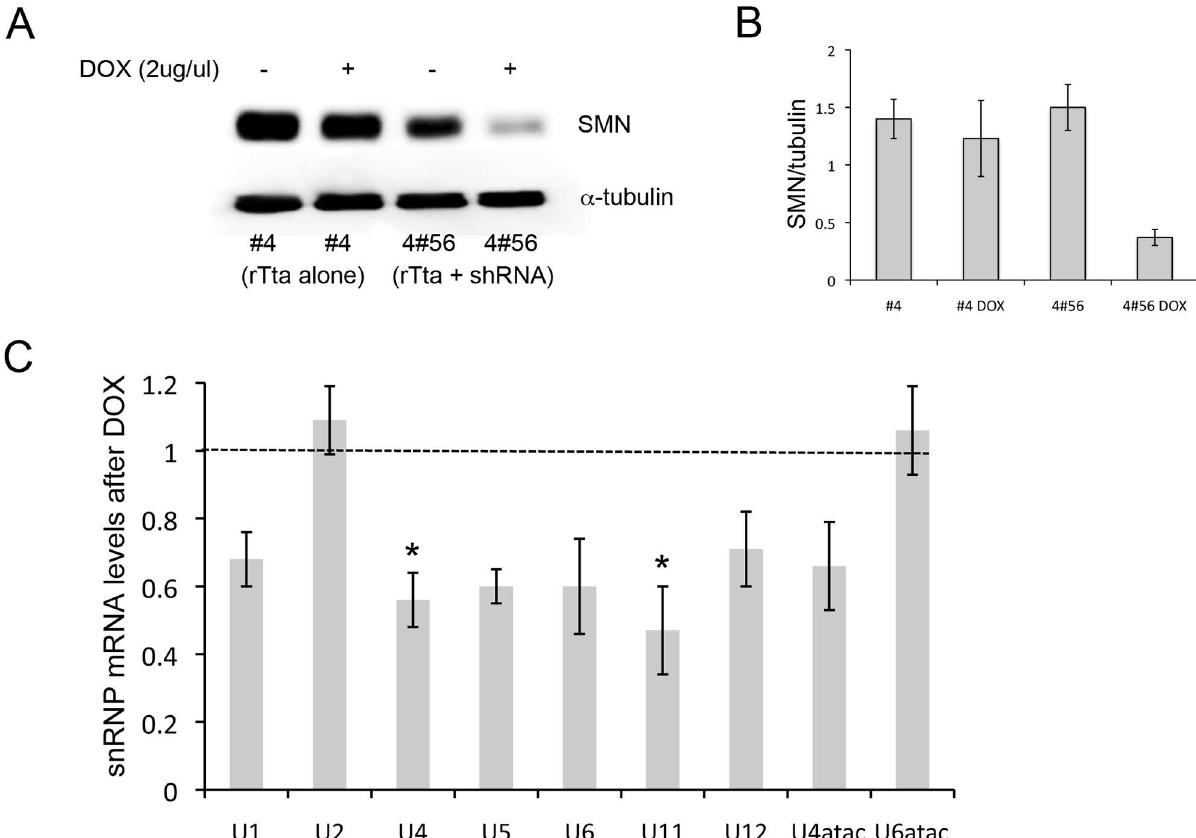
Fig 1. SMN depletion leads to defective U-snRNP biogenesis. A) Doxycycline treatment (2 μ g/ml) for 72 hrs reduced SMN protein levels by ~70% in NSC-34-4#56, which contain both the RTta and the SMN shRNA but not NSC-34 cell clone 4 which expresses only the RTta. B) Quantification of three separate western blot of SMN protein level after doxycycline treatment in NSC-34-4#56. C) Quantitative RT-PCR shows mRNA levels of UsnRNPs after doxycycline-inducedSMN depletioncompared to untreated cells (dashed line). All samples were compared to levels of the 18S subunit. * – p < 0.01.One-way ANOVA followedby post-hoc